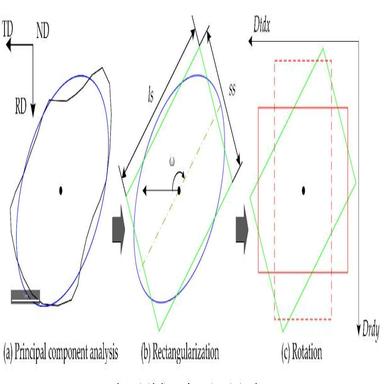
2D grain size distributions.